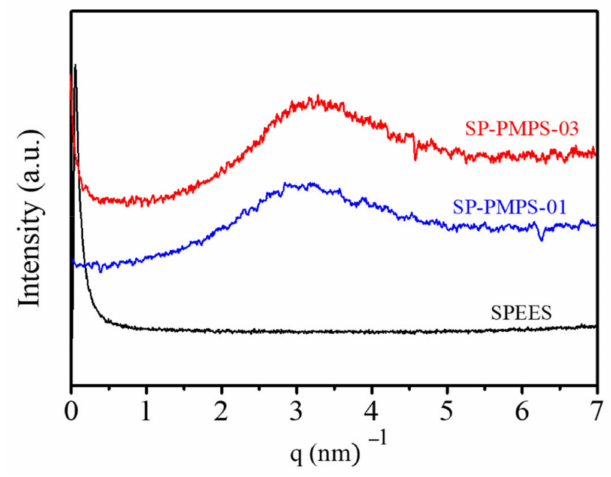
Figure 6. Small Angle X-ray Scattering (SAXS) pattern of SPEES and SP-PMPS membranes.